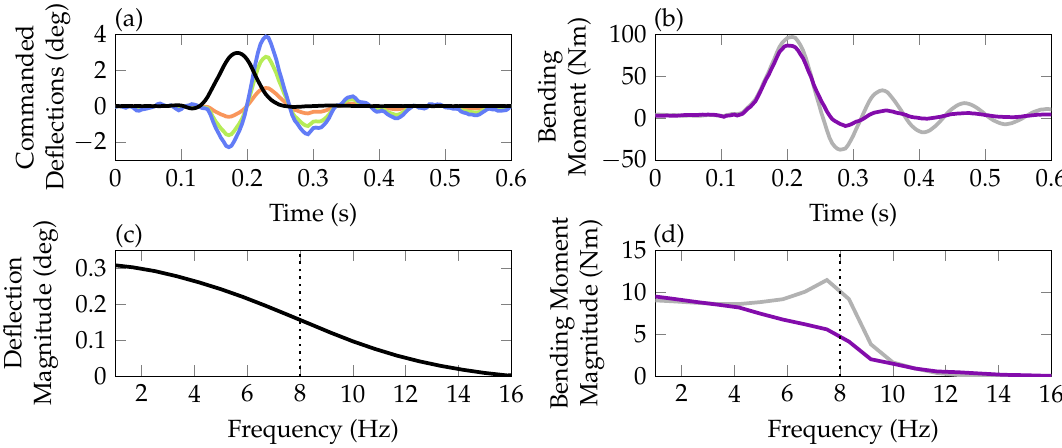
Figure 10. Input and output data for a 1-cosine pitch excitation in the time domain in ( a , b ) and in the frequency domain in ( c , d ). In ( a , c ) the pitch excitation signal ( ) is depicted. In ( b , d ) the open-loop ) bending moments are compared. Additionally, closed-loop inner (